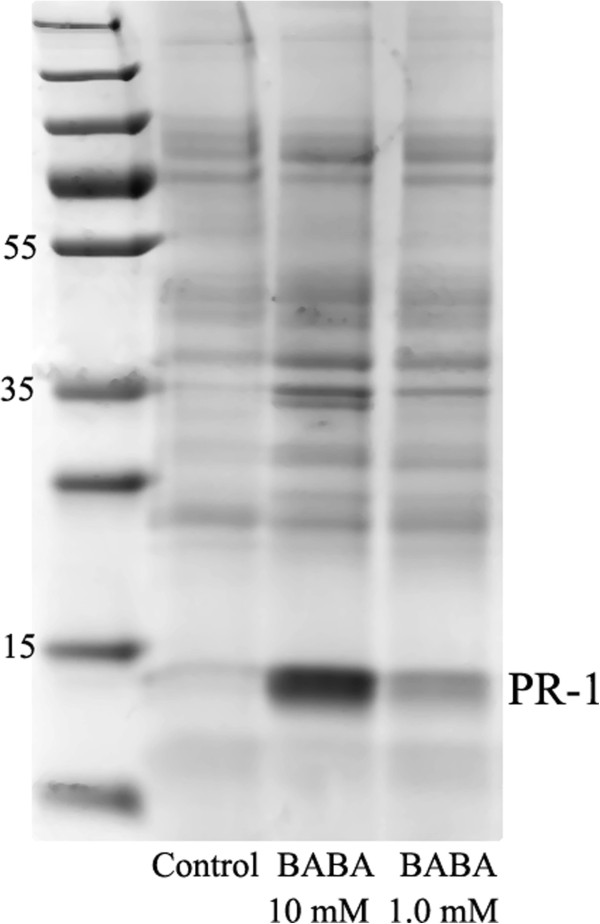
SDS-PAGE of apoplast from Desiree leaves treated with BABA. Separation on a SDS-PAGE gel, showing apoplast proteins extracted two days after treatment with BABA in cv. Desiree. From left: control plant treated with water, plant treated with 10 mM BABA and plant treated with 1 mM BABA. The ladder used was Page Ruler™ Plus Prestained Protein Ladder (SM1811, Fermentas).